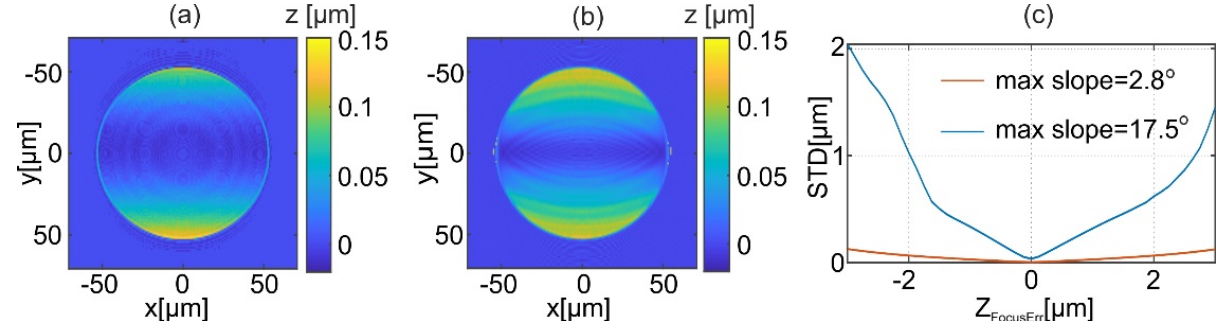
Figure 6. The difference of shapes obtained using LSF for defocus z d = − 1 μ m for object of maximum slope 2.8° ( NA = 0.025) ( a ) and 17.5° ( NA = 0.15) ( b ). The standard deviation of shape reconstruction error as a function of defocus error for two different objects ( c ). The calculations are performed for the geometrically frequency illumination scanning (Figure 3b).